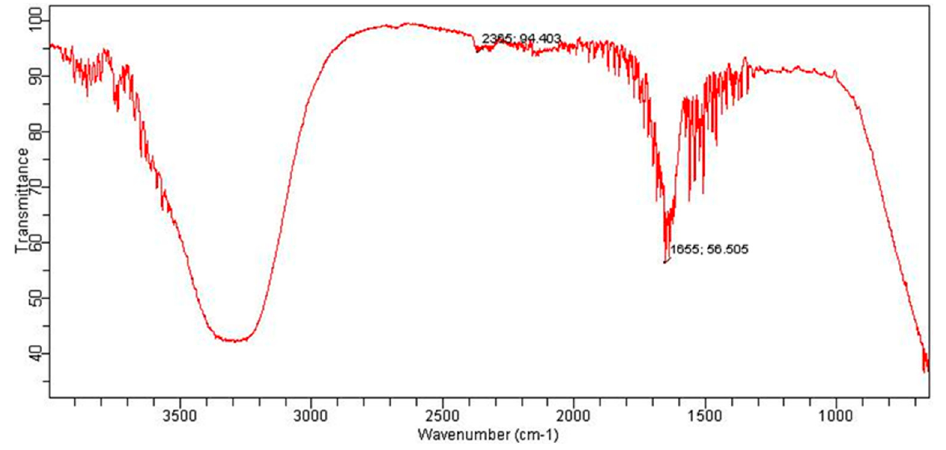
Figure 6. FTIR spectrum of WBC.